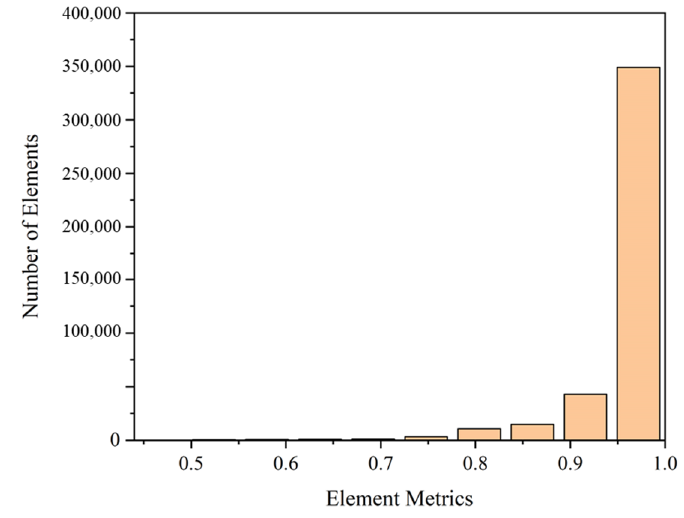
Figure 5. Quality check results of the generated mesh.